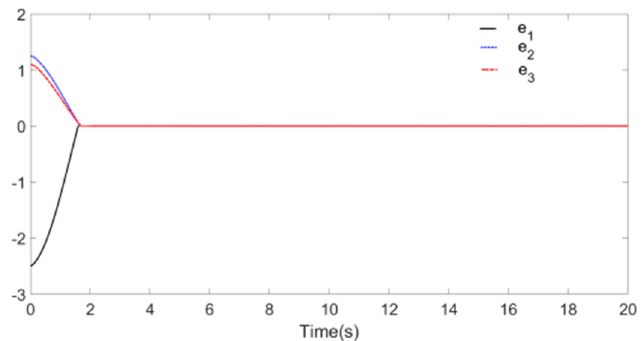
Figure 10. Synchronization of x 3 and y 3 .